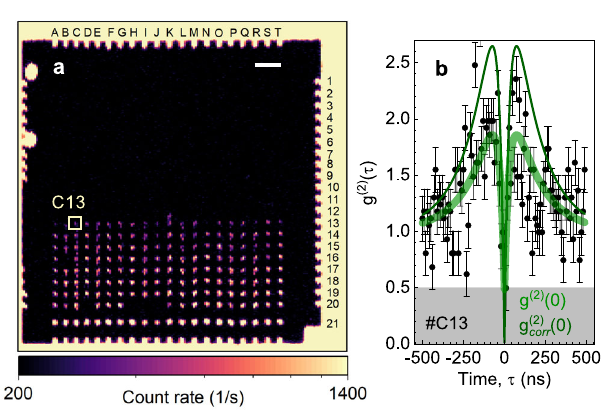
ismeasuredwithaBP fi lter Δ λ =50nmat λ =1225nm.Thesolidlineisa fi ttoEq.(4). d PLspectrumfromtheframeandasingleWcenter( # I14).IntegrationovertheZPL and PSB yields a Debye – Waller factor DW=32%. The BG contribution is schemati- cally shown by the shaded area. e The occurrence probability of W centers for FIB implantation with, on average, 384 Si ions per spot. The solid line represents the sub-Poisson distribution with μ =4.8, as described in the text. The error bars represent